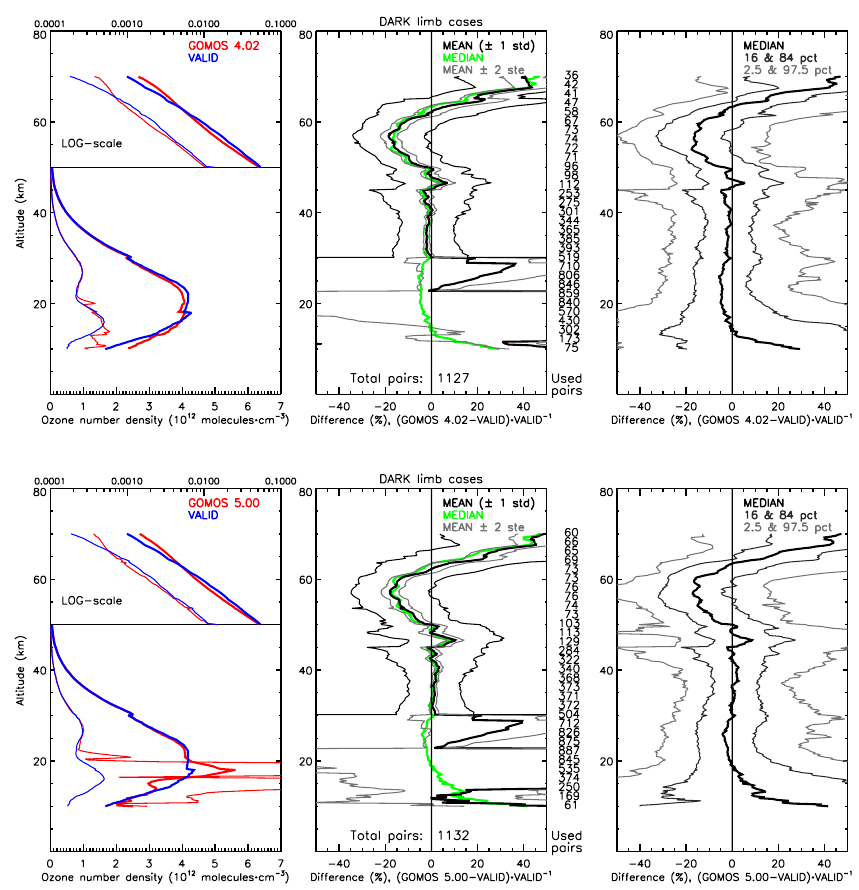
Fig. 1. GOMOS 4.02 (top) and 5.00 (bottom) versus validation data. Left panels show the ozone number density as a function of altitude, with the GOMOS profiles in red and the validation data in blue (mean and standard deviation in thick and thin lines respectively). The ozone concentration is plotted on a log-scale for the upper 30km. The middle panels show the difference between GOMOS and the validation data (with respect to the validation data) in percentage as a function of altitude. The green line shows the median difference profile, the black lines the mean (thick black line) plus/minus 1 standard deviation (thin lines) and the grey lines show the mean plus/minus 2 standard errors. On the right side of the middle panel the number of collocated pairs is shown, with the total number of used pairs at the bottom of the plot. The right panel shows the median difference (thick black line) together with the 16 and 84 percentiles (dark grey lines) and the 2.5 and 97.5 (light grey lines)